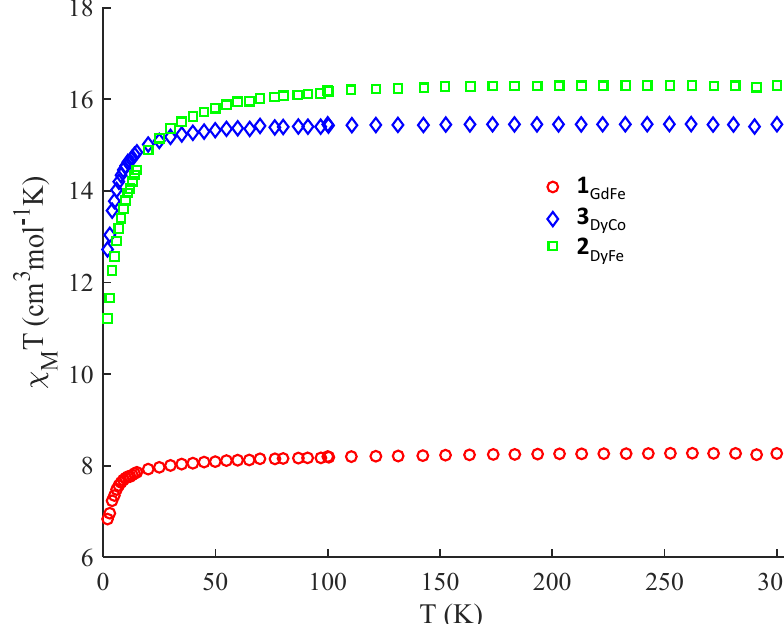
Figure 7. Temperature dependence of χ M T vs. T for complexes 1 GdFe , 2 DyFe , and 3 DyCo . Dynamic magnetic characterizations. Dynamic magnetic properties of the compounds 1 GdFe , 2 DyFe , and 3 DyCo were studied by measuring the temperature and field dependence ac (alternative current) magnetic susceptibility. Compound 1 GdFe does not have any manifestation of the out-of-phase component ( χ ” ac ) of the ac magnetic susceptibility at 2 K and zero dc (direct current) field. After applying small dc field (2000 Oe) no modification was observed in χ ” ac component of ac susceptibility.